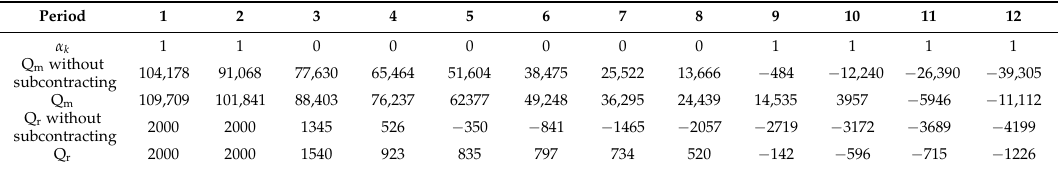
Table 5. Amount of emitted carbon during the different process with ξ = 6.3.